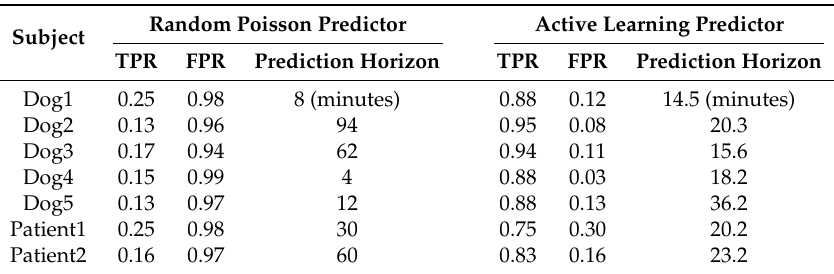
Table 16. Performance of the Support Vector Machine classifier in terms of False Positive Rate (FPR) and False Negative Rate (FNR) for the overall dataset using set t feature